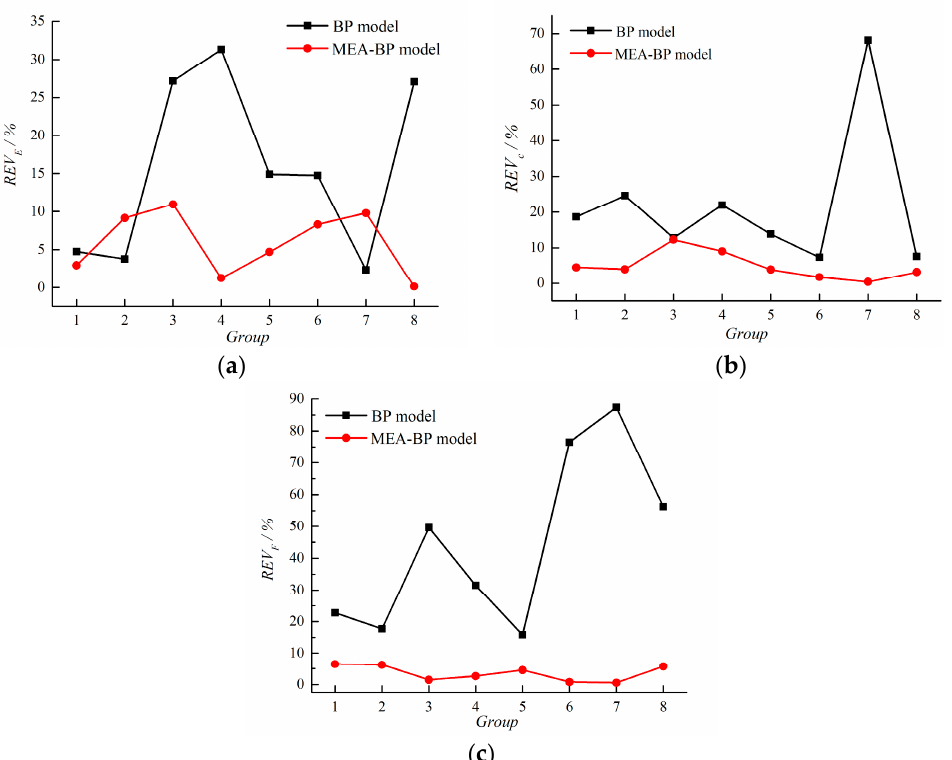
Figure 10. Comparison between the BP model and MEA-BP model. ( a ) Elastic modulus. ( b ) Cohesion. ( c ) Friction angle.